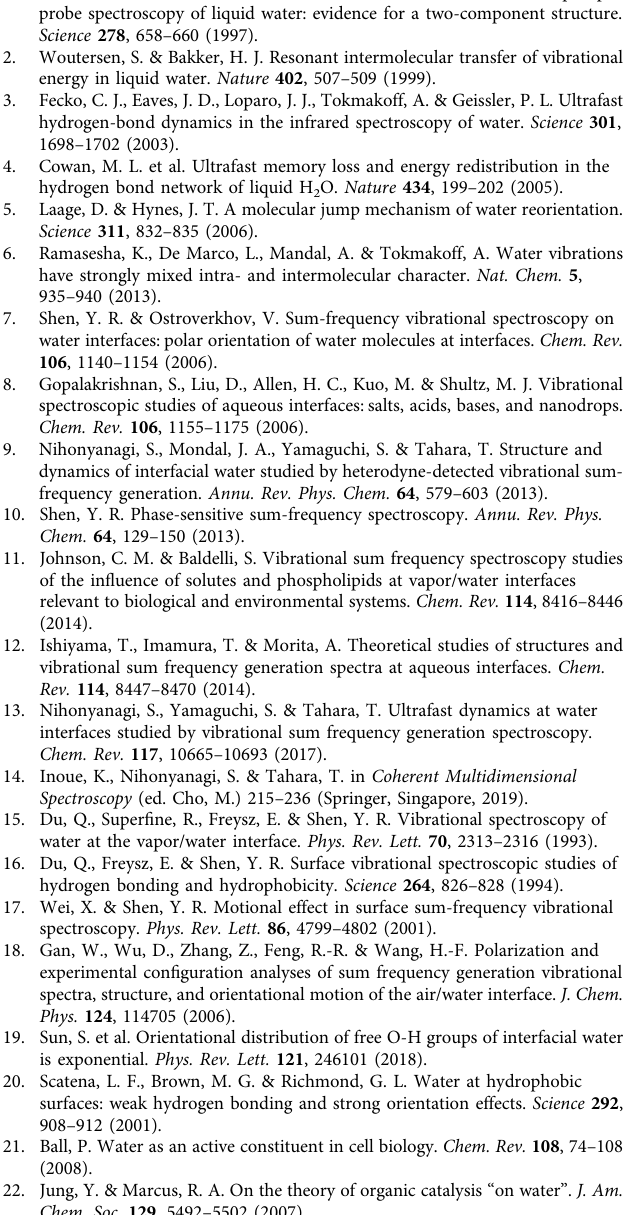
Fig. 6 Schematic of the vibrational relaxation mechanism of the excited free OH. When a free OH is vibrationally excited (process 1), the excited free OH diffusively reorients (process 2) to form an excited-state HB OH (process 3). The excited HB OH rapidly relaxes to the lower energy vibrational states (process 4). Finally, the pump energy absorbed by water converts to the thermal energy (process 5). Dotted OH bonds represent the vibration in the excited